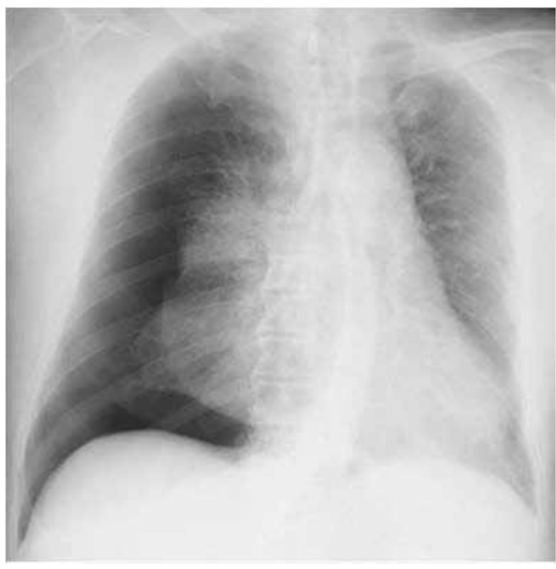
Figure 1. Chest radiograph on admission revealed pneumothorax of the right.